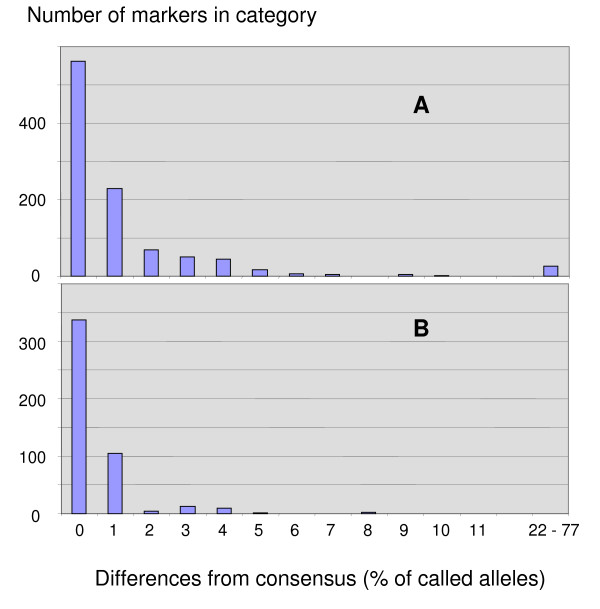
Markers with potential scoring errors. Frequency distribution of percent agreement between called alleles and consensus calls for DArT markers with clones belonging to multi-sequence contigs. For contigs with two members, this is the percent agreement with the other clone in the contig. Part (A) is based on diversity scores for 1015 clones belonging to 431 contigs, and part (B) is based on mapping scores for 485 clones belonging to 194 contigs.